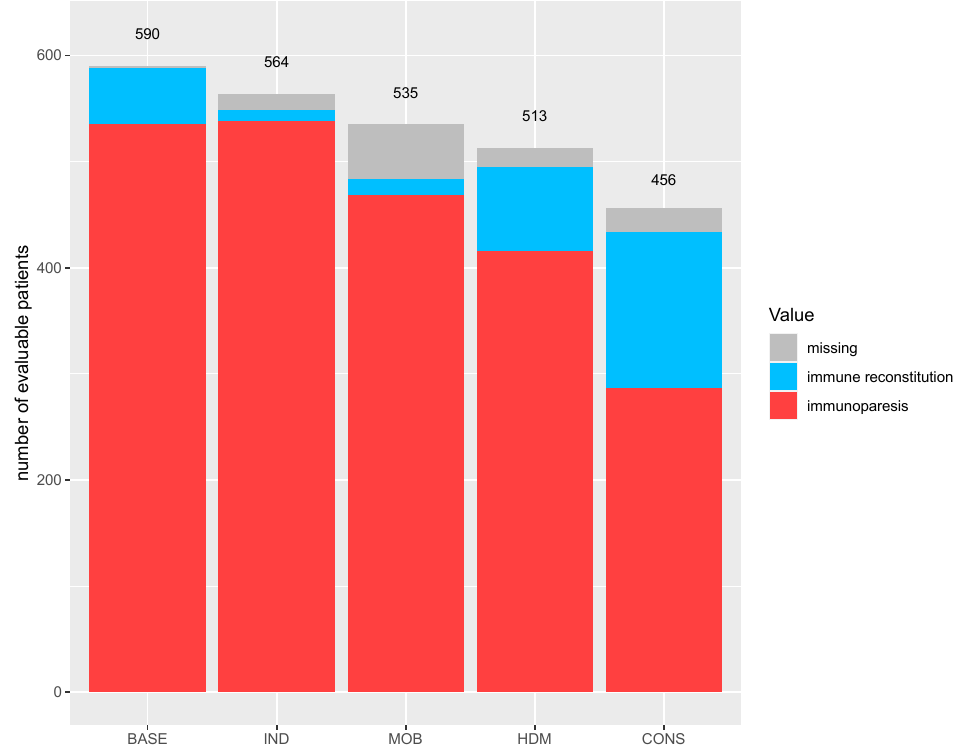
Figure 4. Immune reconstitution during first-line therapy in the MM5 trial. The number of evaluable patients is represented by the number of patients on study at the start of each treatment phase. Table 3. The impact of achieved immune reconstitution until the start of maintenance at the latest on PFS and OS. The results of the time-dependent multivariate Cox regression